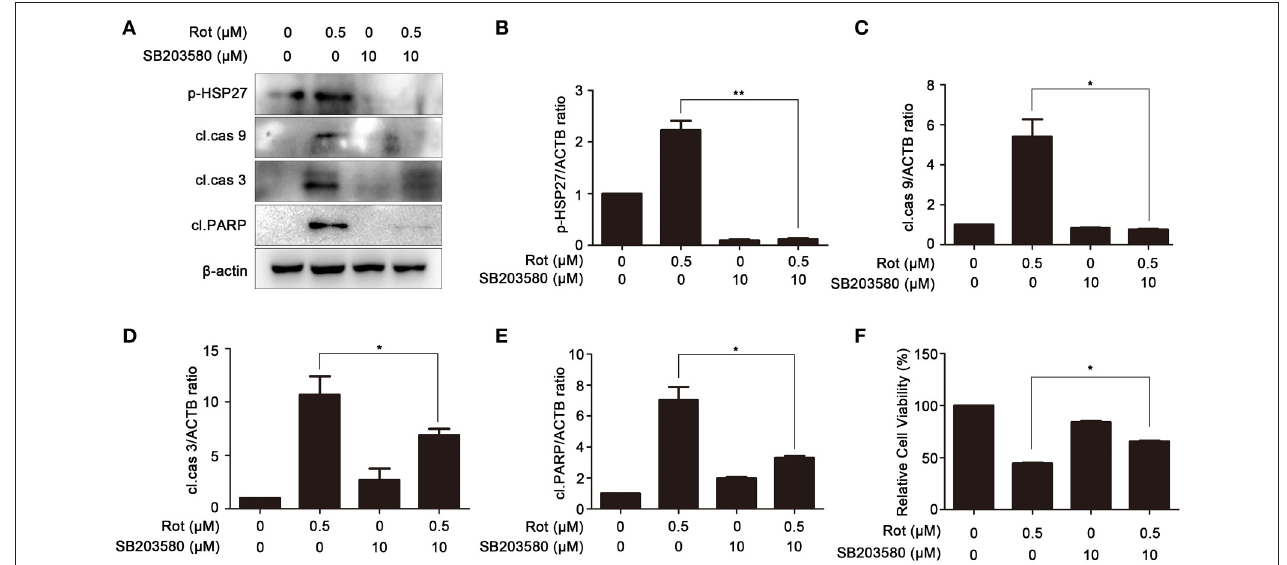
FIGURE 5 | Inhibition of p38 signaling prevents rotenone-induced apoptosis. (A) The SH-SY5Y cells were pretreated with 10 µ M SB203580 (SB) for 1h, and then treated with rotenone for 36h, cleaved caspase-9, cleaved caspase-3, cleaved PARP and p-HSP27 were detected by western blot, β -actin was used as a loading control. Results are representative of at least three experiments. The levels of p-HSP27 (B) , cleaved caspase-9 (C) , cleaved caspase-3 (D) , cleaved PARP (E) were quantified by densitometry. * p < 0.05, ** p < 0.01, compared with rotenone-treated group. (F) In the presence or absence of SB, cells were treated with rotenone for 36h, cell viability was assessed by MTT assay. Data are expressed as percent of values in untreated control. * P < 0.05, compared with rotenone-treated cells.